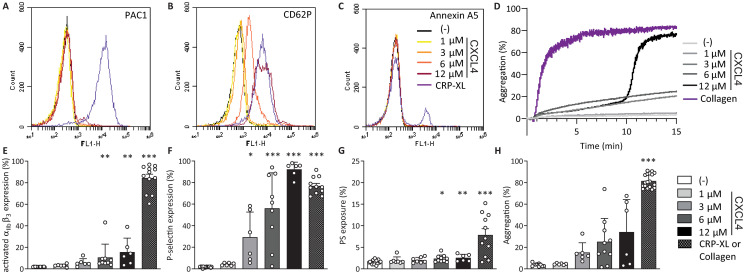
CXCL4 induces different platelet responses.Flow cytometry measurements of platelets, assessing activation of integrin αIIbβ3 and P-selectin using fluorescently labelled PAC-1 (A), anti-CD62-P (B), and annexin A5 (C), respectively. Representative histograms represent washed platelets incubated with different concentrations of CXCL4 (A-C) or 1 μg/mL CRP-XL for 15 minutes and bar graphs showing the percentage of platelet αIIbβ3 activation (E), P-selectin expression (F) and PS-exposure (G) by CXCL4. Light transmission aggregometry of washed platelets (D) and quantification (H), incubated with different concentrations of CXCL4 or 5 μg/mL collagen for 15 minutes. Bars represent mean ± SD (n = 3-5 measured in duplo). *p < 0.05, **p < 0.01, ***p < 0.001 as compared to control (Kruskal Wallis/Dunn’s test).